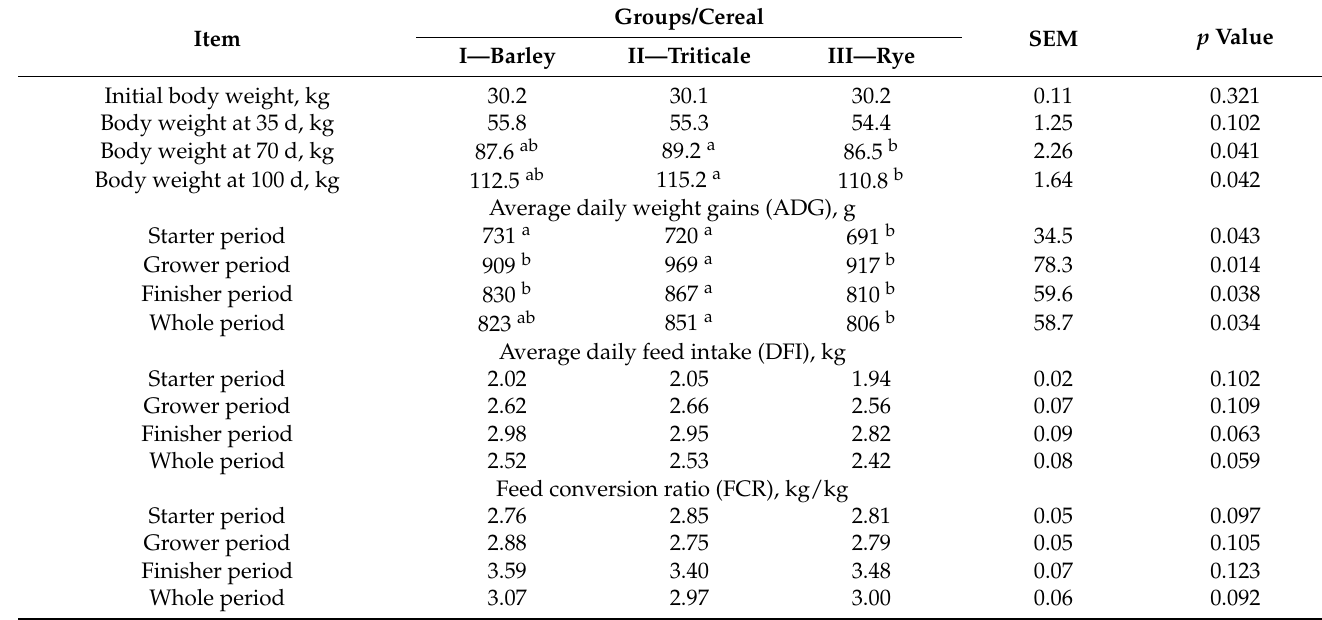
Table 3. Productive performance of pigs during the 100 days of fattening experiment.